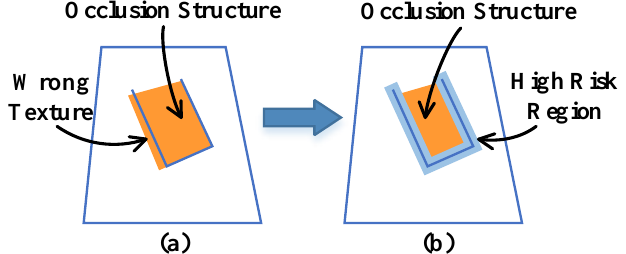
Figure 5. Description of edge error weight field modeling. ( a ) shows the problem of the wrong texture in the edge area of the scene, ( b ) shows that the high-risk area can be marked and the data reliability of these areas can be adjusted to avoid the wrong texture.